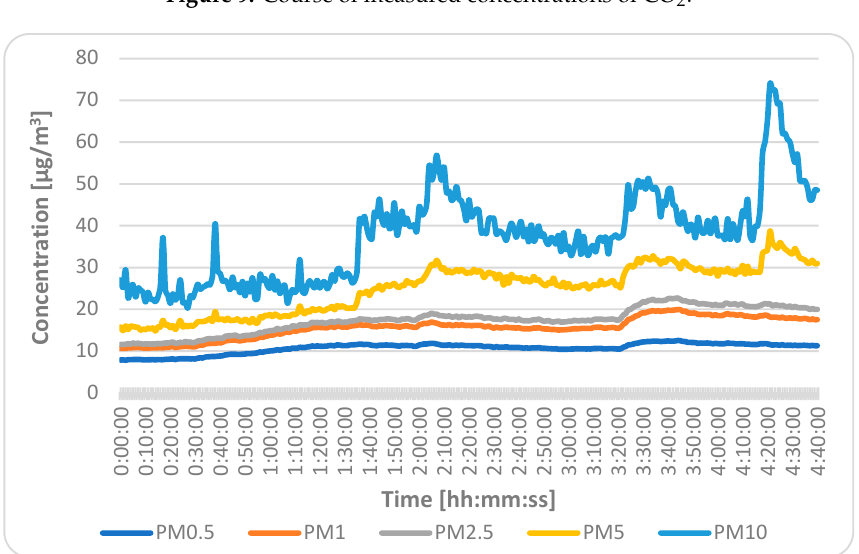
Figure 9. Course of measured concentrations of CO 2 .